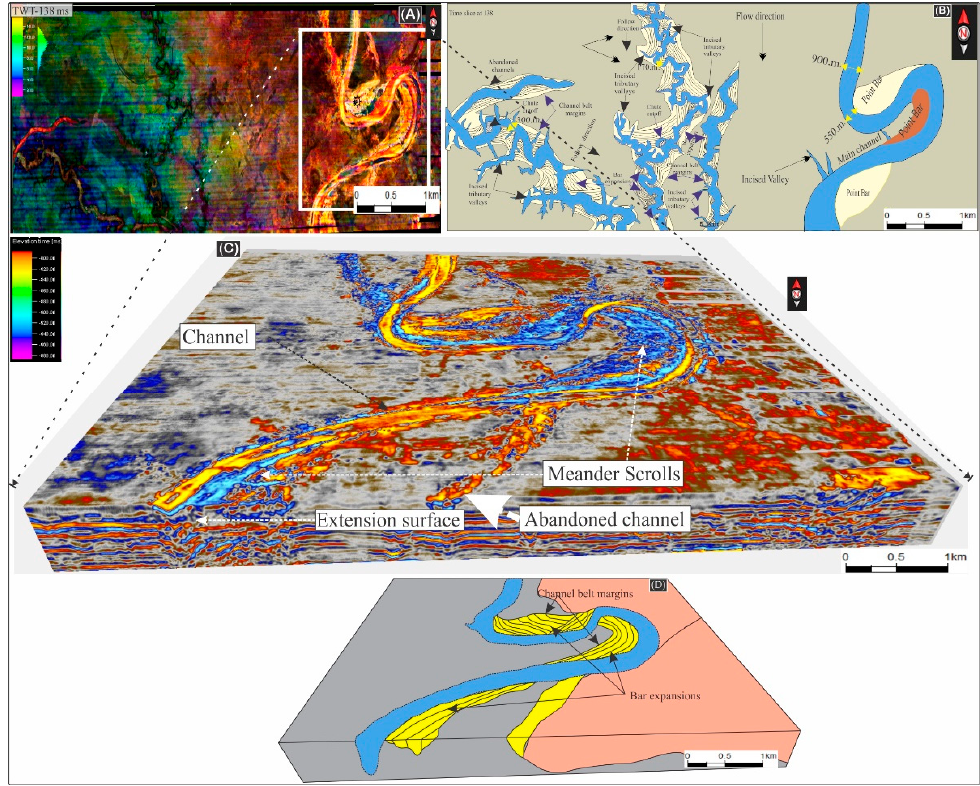
Figure 7. The block diagram illustrating the relationship between channel-fill shapes in the cross- sections and their chart-view interpretation was noticed at TWT of around − 138 ms. ( A ) represents the RGB color blending seismic attribute at − 138. The time slice of chart view-imaged Figure B represents well-conserved channel, and channel-belt muddy depositional features, highlighting the channel variation sizes shown in ( B ). The channel’s seismic amplitude is quite different from the surrounded point bars deposits in both the 2D seismic sections and the 3D time slices, as shown in ( C ). The 3D amplitude volume reveals the biggest sinuosity channel crosses the Melor field; blue colors indicate the meander scrolls while the yellow color infers the sandy bodies filling the channel parts while others are filled with clay. However, ( D )’s chart is an interpreted edition of the 3D seismic amplitude volume, displaying sand-prone facies in orange, mud-prone channel facies in blue, point bars in yellow interfluve in gray and orange.